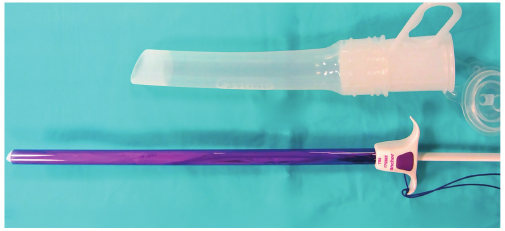
Figure 5: McCartney tube as an alternative to pneumo-occluder.